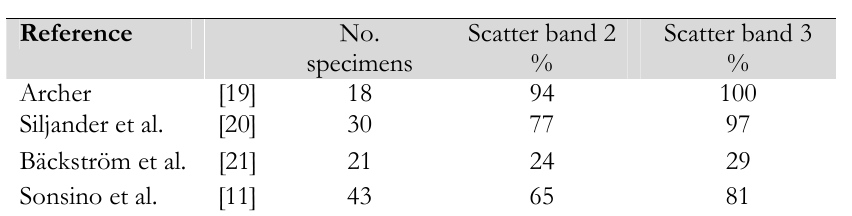
Table 1: Percentage of the results included into the scatter bands with coefficients 2 and 3, for each experimental data set analysed [11,